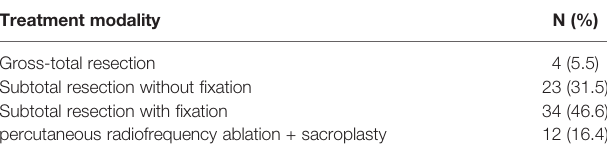
TABLE 3 | Treatment modality of the 73